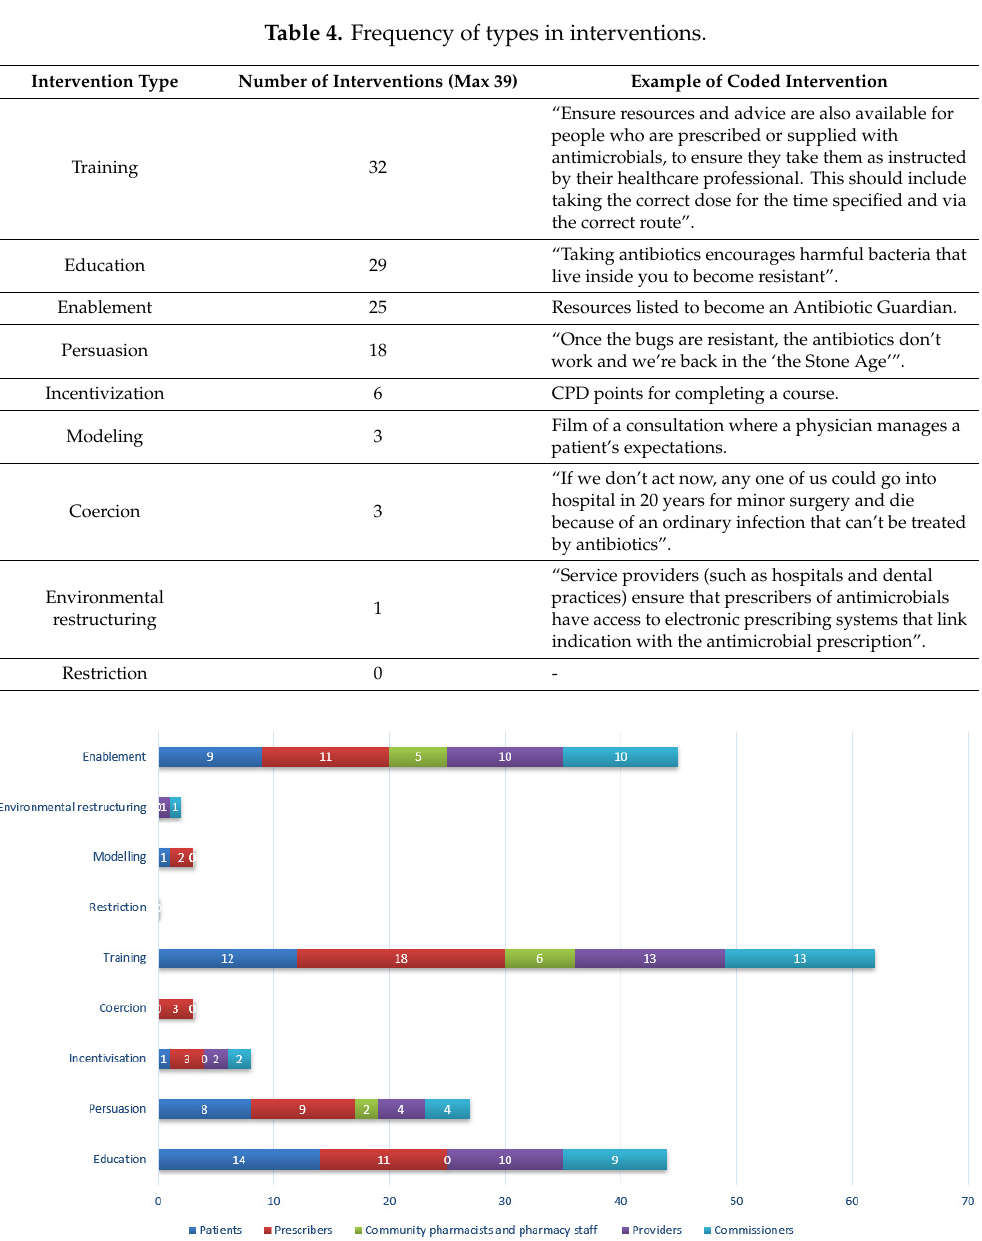
Figure 1. Frequency of identification of intervention types by target group. Total count will exceed the maximum number of interventions ( n = 39) as many interventions were aimed at more than one target group.